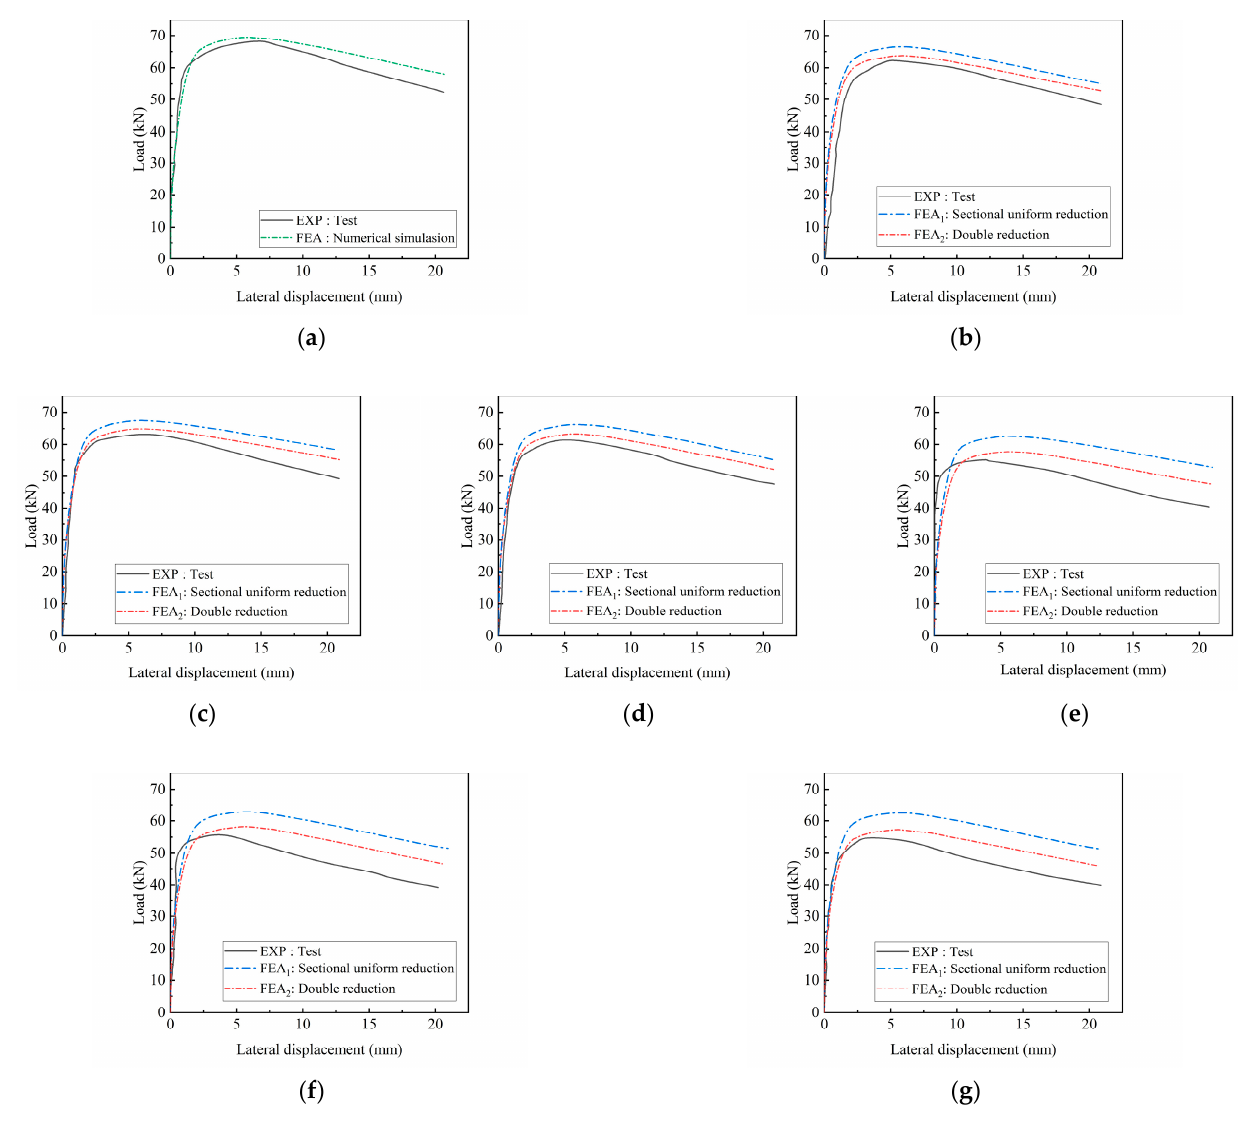
Figure 19. Comparison between the load–lateral displacement curves obtained from the test and numerical simulations: ( a ) Test beam A01; ( b ) Test beam A11; ( c ) Test beam A12; ( d ) Test beam A13; ( e ) Test beam A21; ( f ) Test beam A22; ( g ) Test beam A23.